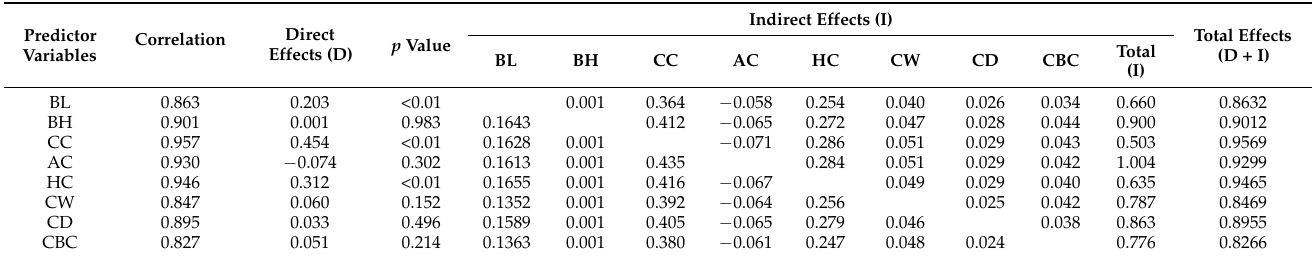
Table 4. Path coefficients for direct and indirect effects of body size indexes on body weight in 60–120 kg stage.